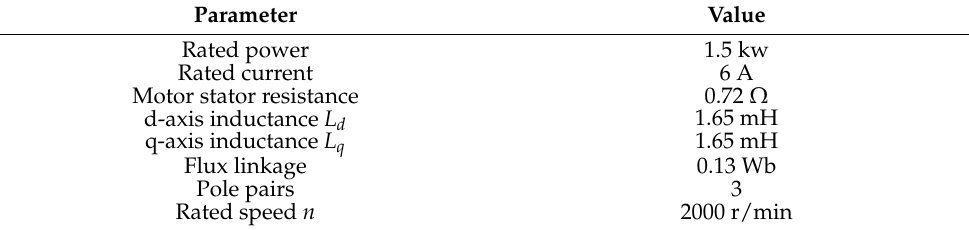
Table 2. Parameters of